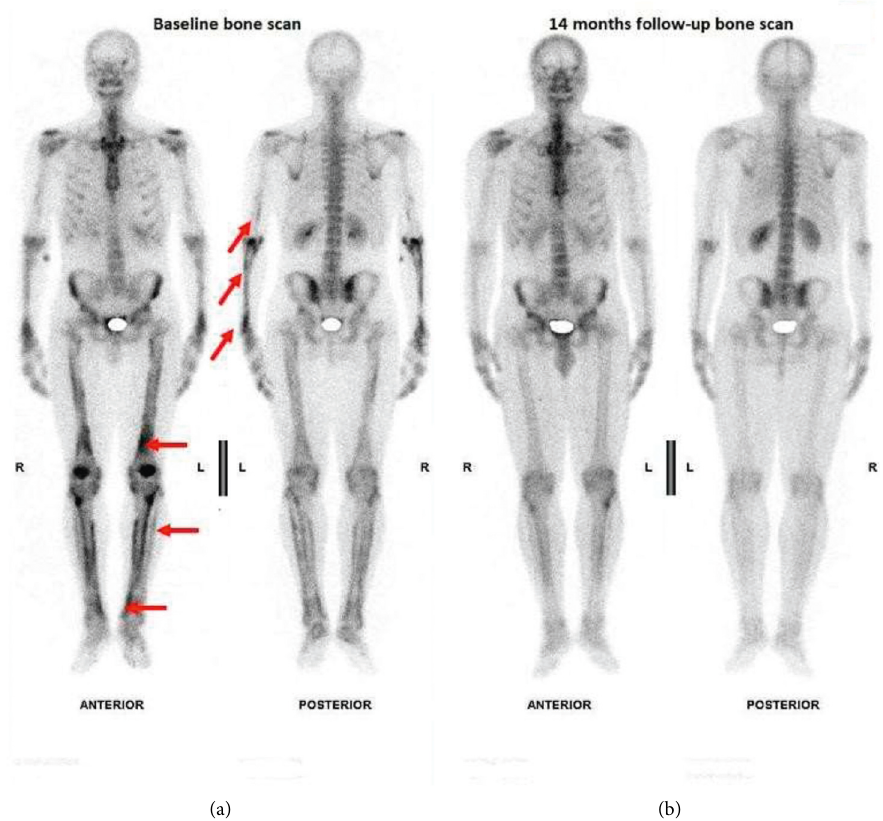
Figure 3: (a) Bone scan showing increased radiotracer uptake (arrow) along the tubular bones of the upper and lower extremities consisting with periostosis. (b) The whole-body scan performed 14 months later showing the improvement of the scintigraphic abnormalities.